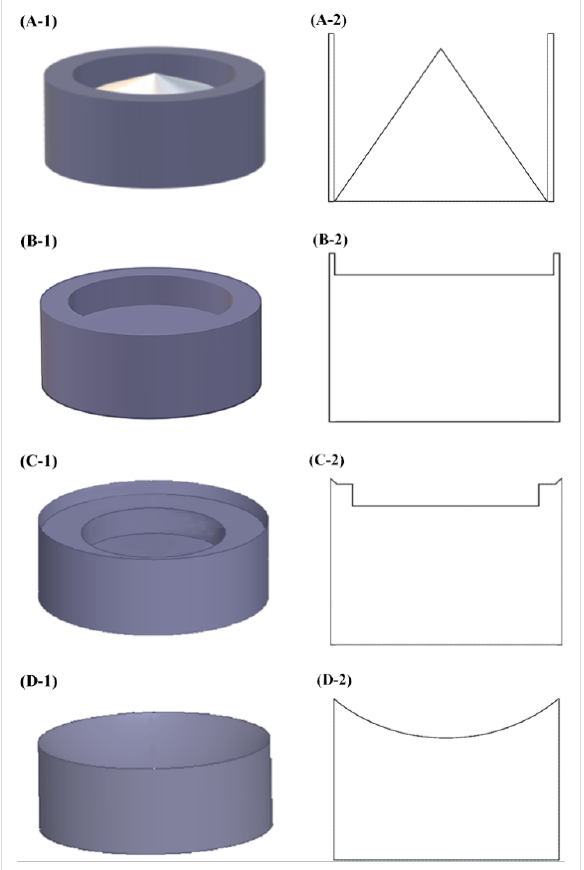
Figure 2: Schematic diagrams of the four solution reservoirs. (A-1), (B-1), (C-1) and (D-1) are the 3D schematic diagrams of the MBE, MFSE, OSFSE and SSFSE device, respectively. (A-2), (B-2), (C-2) and (D-2) are the corresponding longitudinal cross-sectional